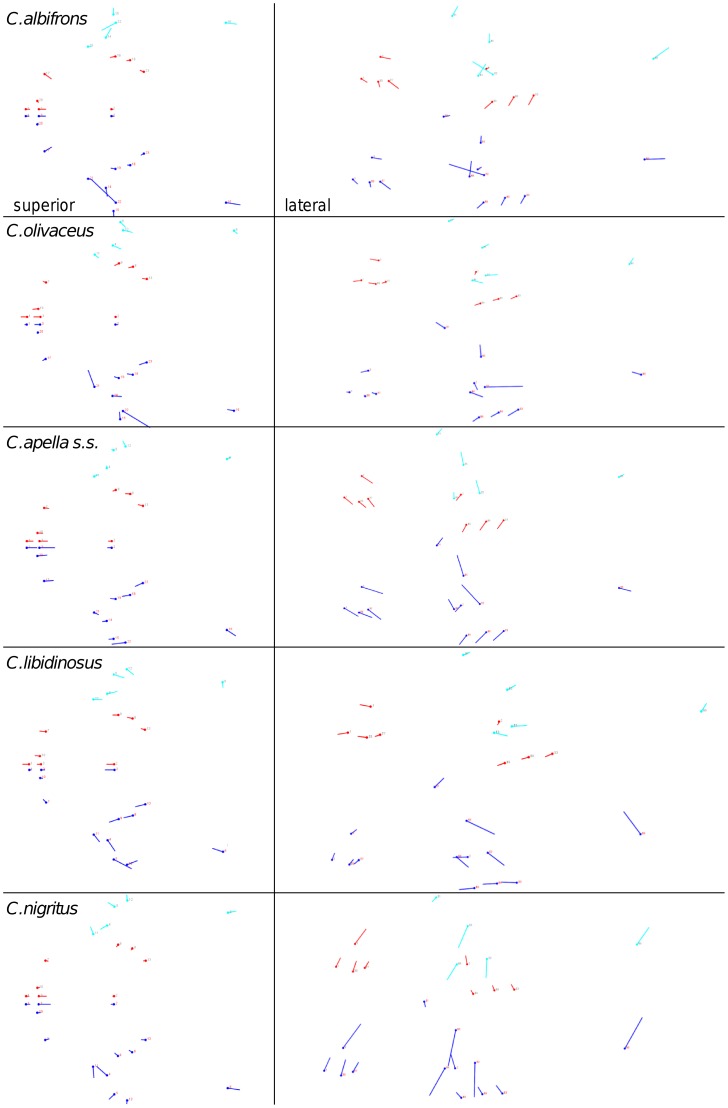
Shape change contained in the non-allometric oral-zygomatic PLS1 and the allometric PC1.Legend: oral-zygomatic PLS1 blocks colored in red and turquoise; PC1: landmark configuration colored in dark blue.